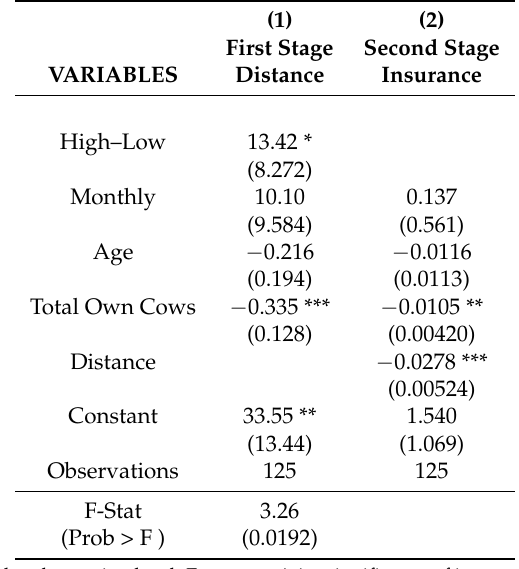
Table A1. First and Second Stage of Table 7, IVPROBIT, and the Effects of Distance on the Uptake of Group